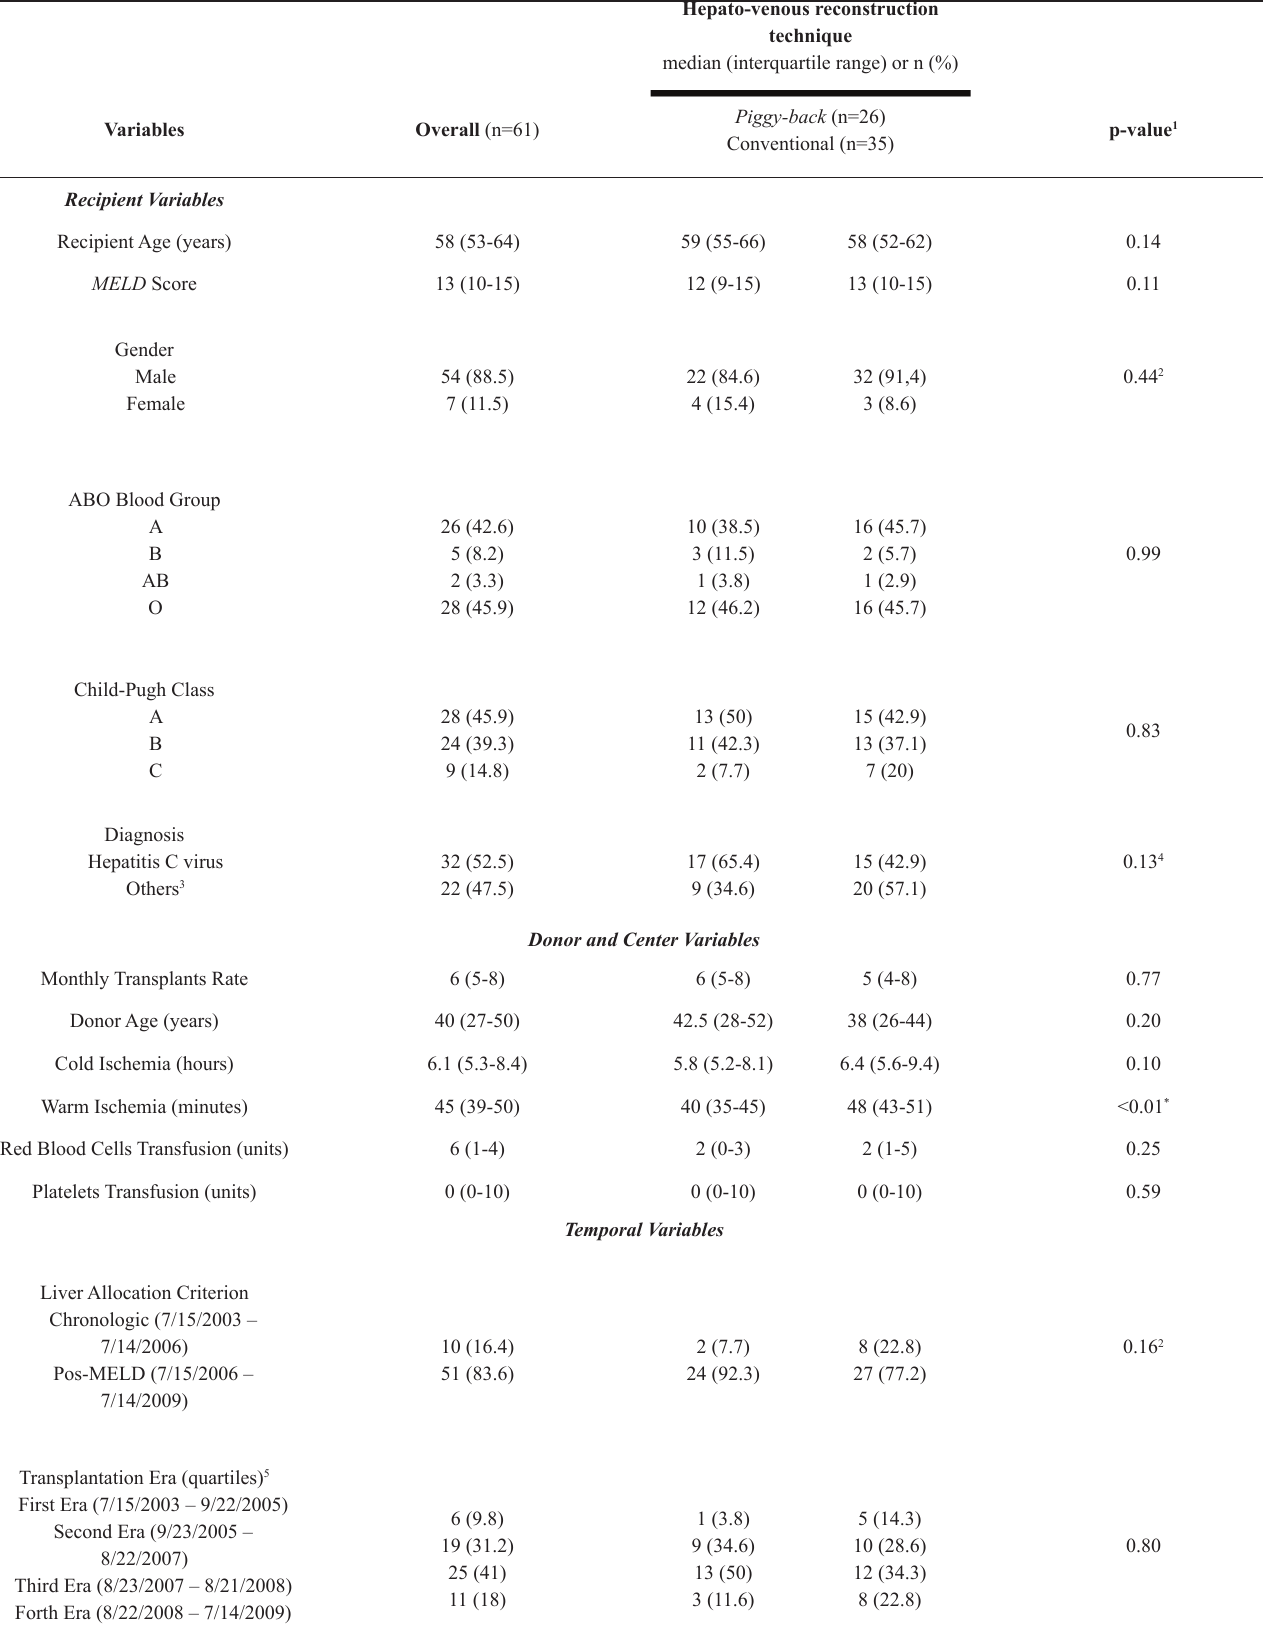
TABLE 1 - Baseline characteristics and descriptive